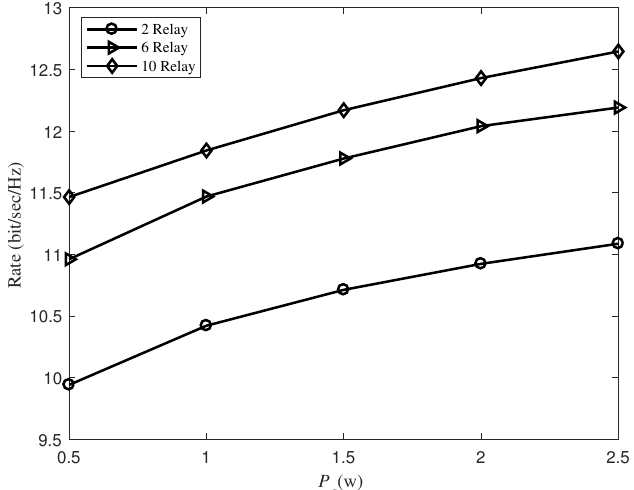
Figure 4. The transmission rate versus the source transmit power P s with different number of relays.